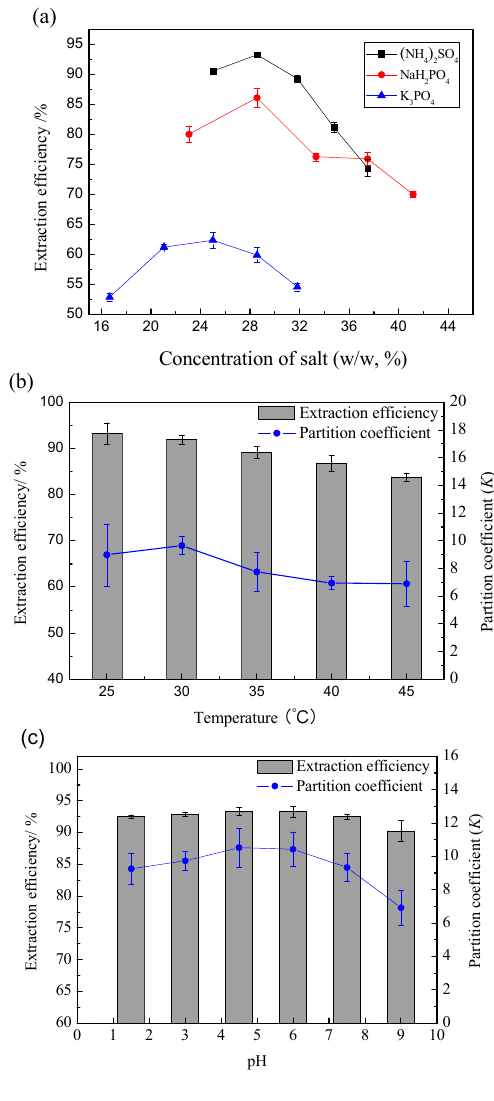
Figure 5. Effect of ( a ) salt type and concentration (each IL-ABS contains a given mass of IL extract and salt at room temperature); ( b ) extraction temperature; ( c ) system pH on the extraction efficiencies.